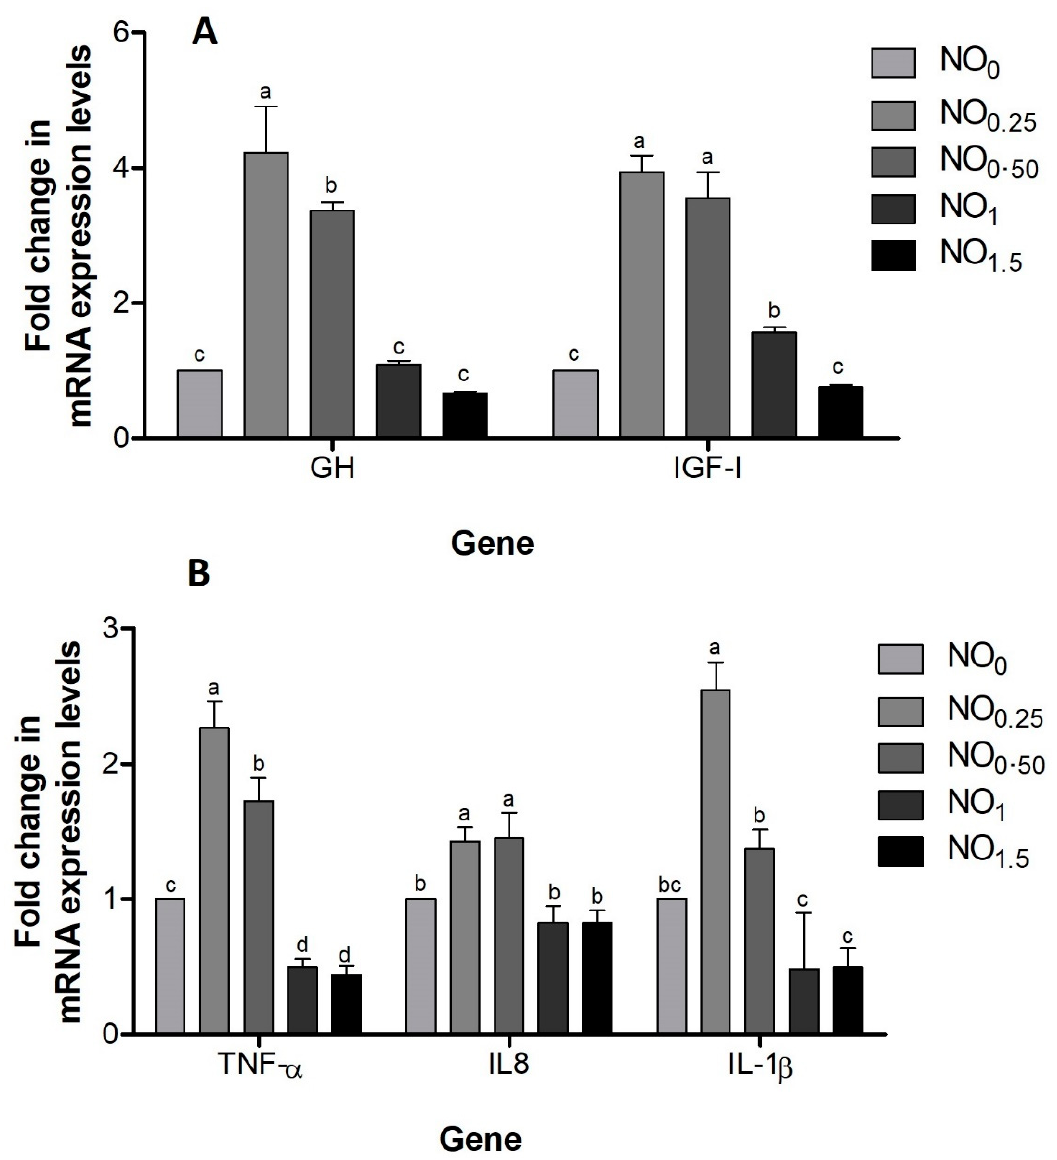
Figure 3. Expression of growth hormone (GH) and insulin growth factor I (IGF-I) in the muscle ( A ) and TNF- α , IL1- β and IL-8 in the head kidney ( B ) of common carp fed on diets with 0 (control), 0.25%, 0.50%, 1.0% and 1.5% neroli oil (NO). n = 6 X ± SD. a,b,c Within a row mean values with different letters are significantly different from the other groups ( p < 0.05).